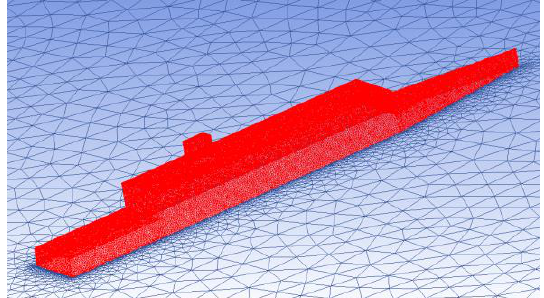
Figure 6. Mesh of SFS2 model.